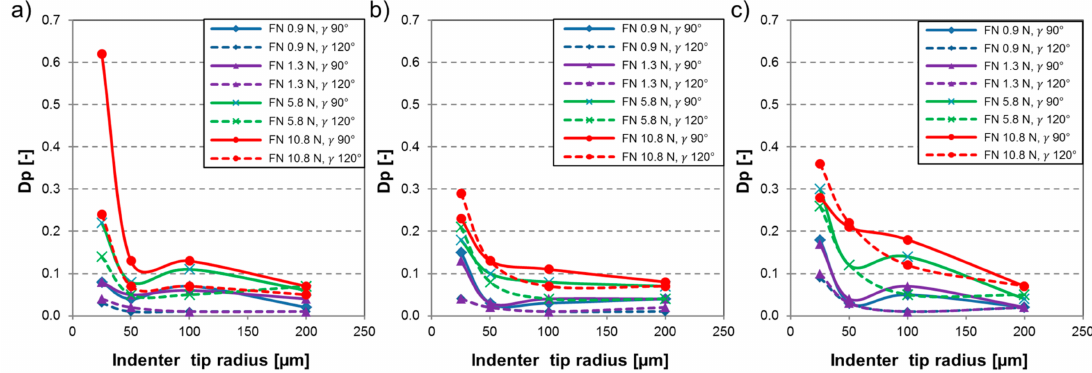
Figure 5. Degree of penetration [-] of wear grooves in function of indenter tip radius ( µ m) with various applied load (F N ) and indenter cone angle ( γ ) for material ( a ) FM, ( b ) TM, ( c )